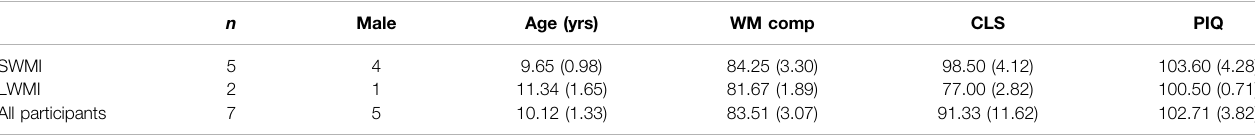
TABLE 1 | Descriptive statistics for participant demographics.